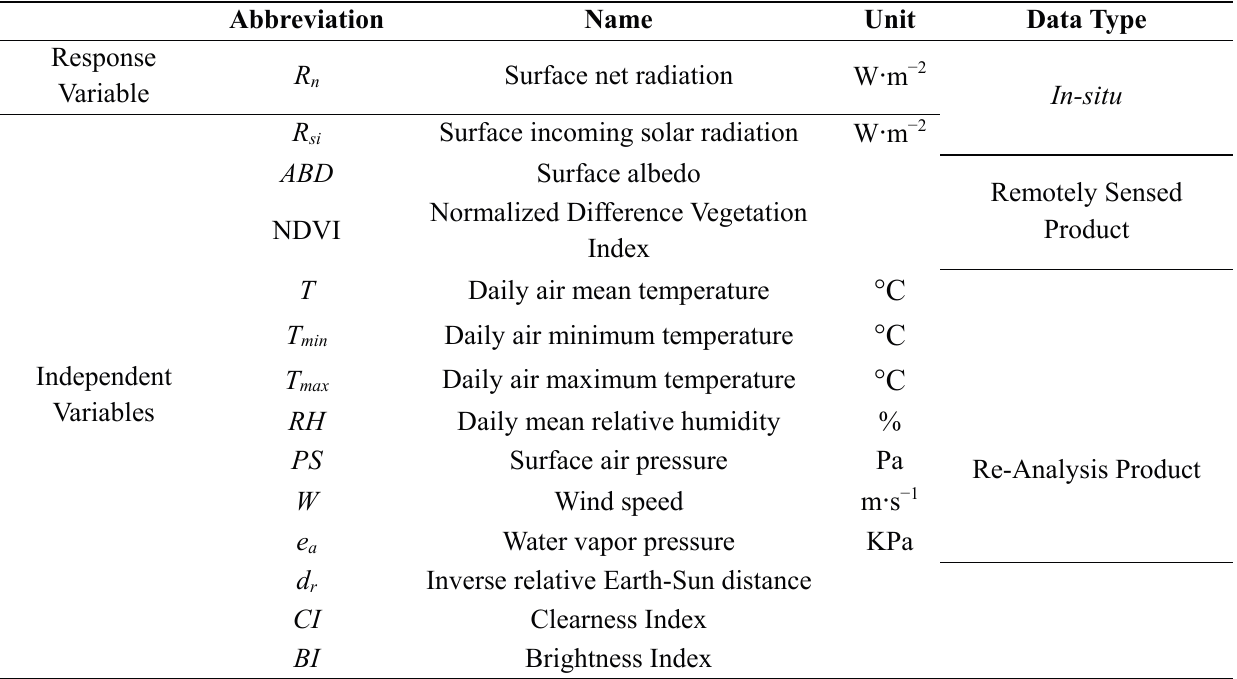
Table 4. Summary of input and response